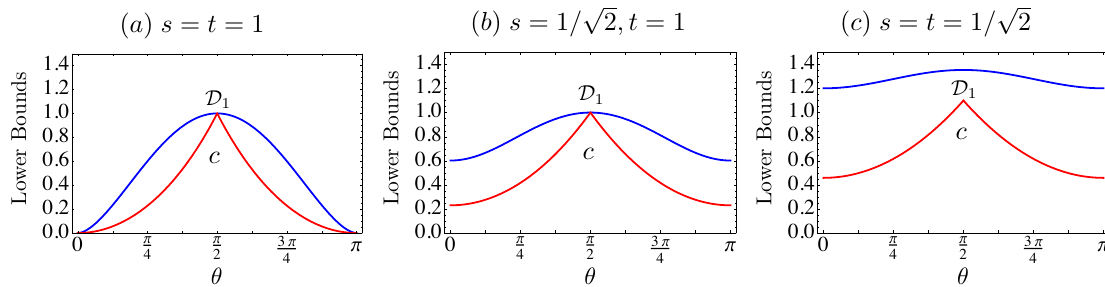
Figure 2. Graphs illustrate the lower bounds in Equation (14) for successive measurement of Z and X ( θ ) with respect to angle θ . Varying unsharpness of the observables, we present three cases. ( a ) At s = t = 1, both observables are sharp; ( b ) At s = 1/ √ 2, t = 1, only the first one is unsharp; ( c ) At s = t = 1/ √ 2, both are